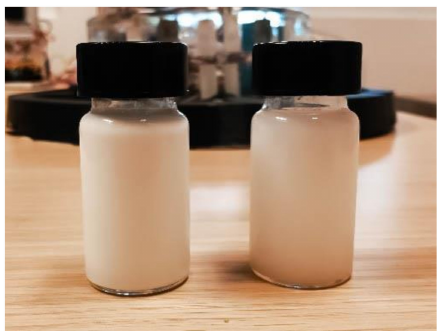
Figure 2. Suspensions of TiO 2 in DIW with volume concentration of 4% (left) and 2%